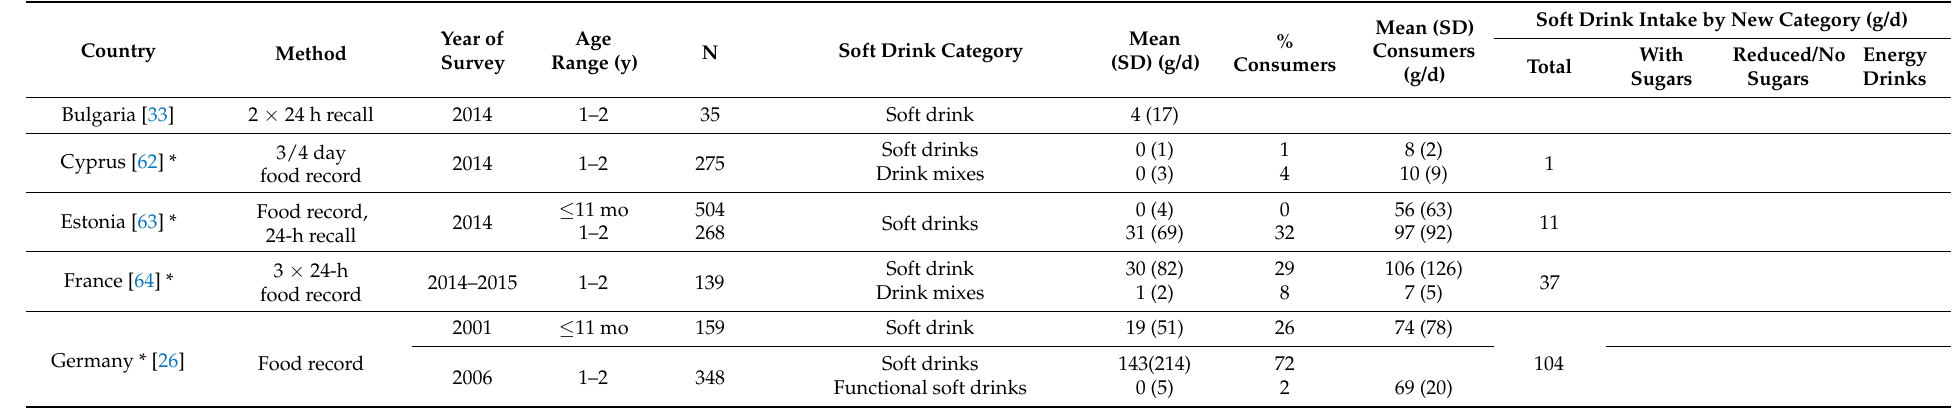
Table 2. Soft drink intake in infants and toddlers (<4 years) in the WHO European Region, as reported in National Dietary Surveys and by new